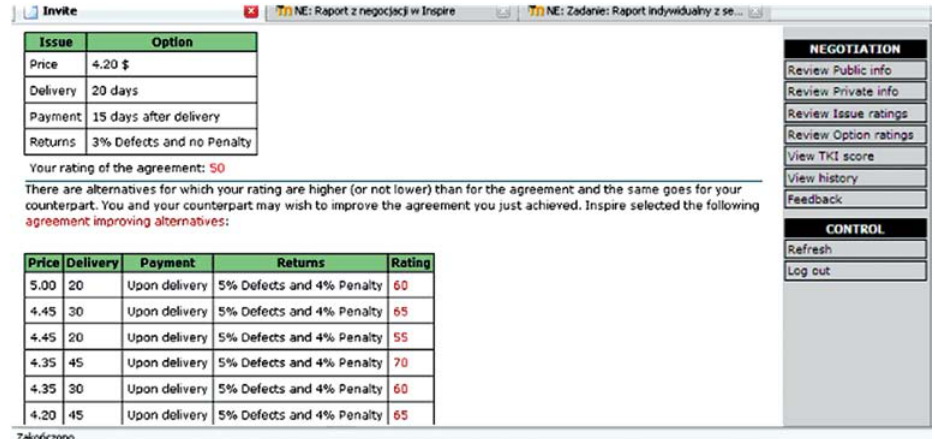
Fig. 9. Improvement of current agreement found by eNS